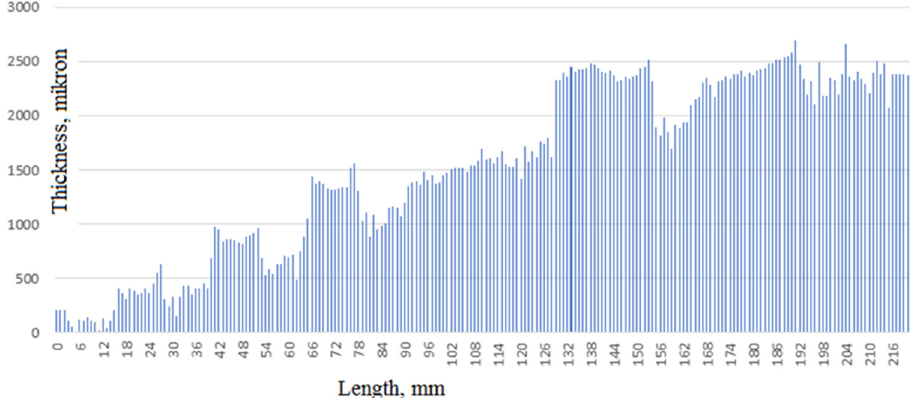
Figure 6. Graph of measuring the profile of the material thickness alongside with the geometric curvature of the base surface.